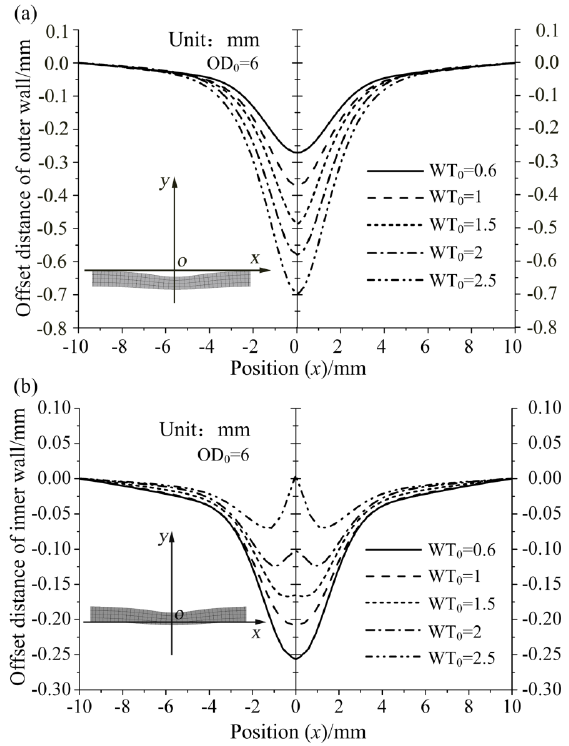
Figure 8. Effect of WT 0 on surface profile at fracture of ( a ) outer wall and ( b ) inner wall.